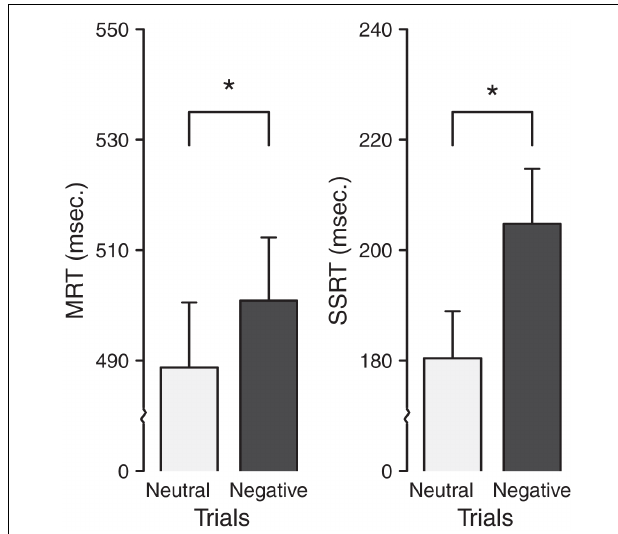
FIGURE 2 | Bar plots depicting performance in Go (left panel) and Stop (right panel) trials (Error bars represent SE). As it can be seen, participants needed more time to give but also stop their responses in the negative trials compared to neutral trials. MRT , median response time; SSRT , stop-signal reaction time. * p < 0.001.